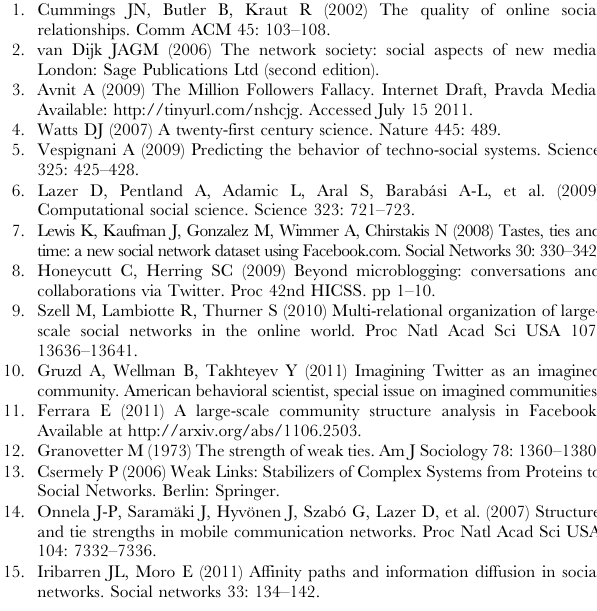
with mentions (E) or retweets (F) and the follower network as function of the size of the group of origin and destination. (PDF) Figure S13 Bridges between groups detected by Moses for the network sample without hubs. (A) Distribution of the links in the follower network (black curve), those with mentions (red curve) and retweets (green curve) as a function of the number of not- shared groups of the users at the extreme of the link. (B) Ratio between these distributions taking the follower network as baseline. (C) Distribution of the number of groups to which each user is assigned. (PNG) Figure S14 Jaccard similarity of users followers. Users similarity frequency for pairs of users connected by a follower link (black circles), by a link with a mention (red squares) and a link with retweet (green diamonds). Inset: ratio between these frequencies taking the follower network as a baseline. (PNG) Table S1 Summary of the results regarding internal connections when the groups are obtained with several clustering algorithms for different samples of the network. We measure the trend of the mentions to concentrate in internal connections. Legend: w - weak signal, sg - signal only for small groups, typically smaller than 10 members, a hyphen is inserted if we have no